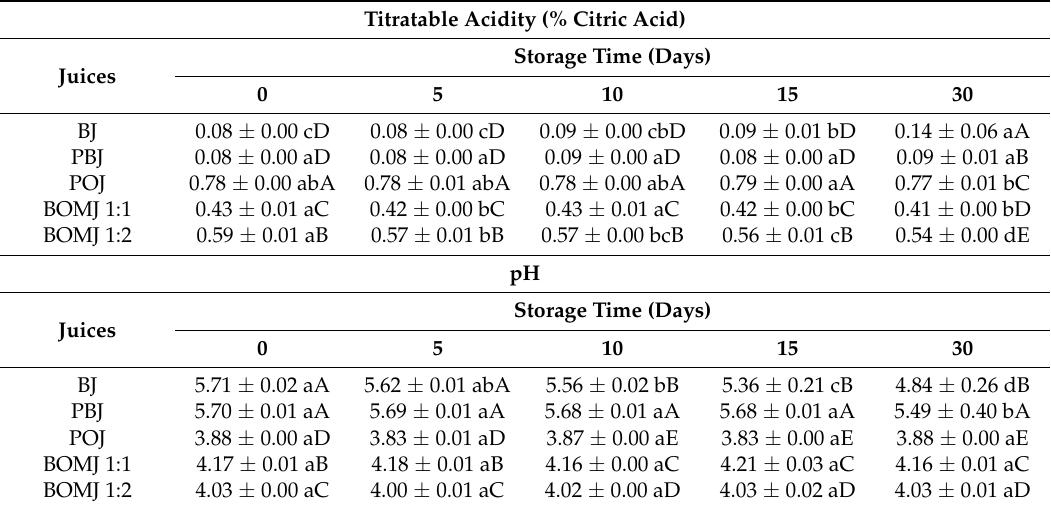
Table 1. Titratable acidity and pH of juices stored at 4 ◦ C for 30